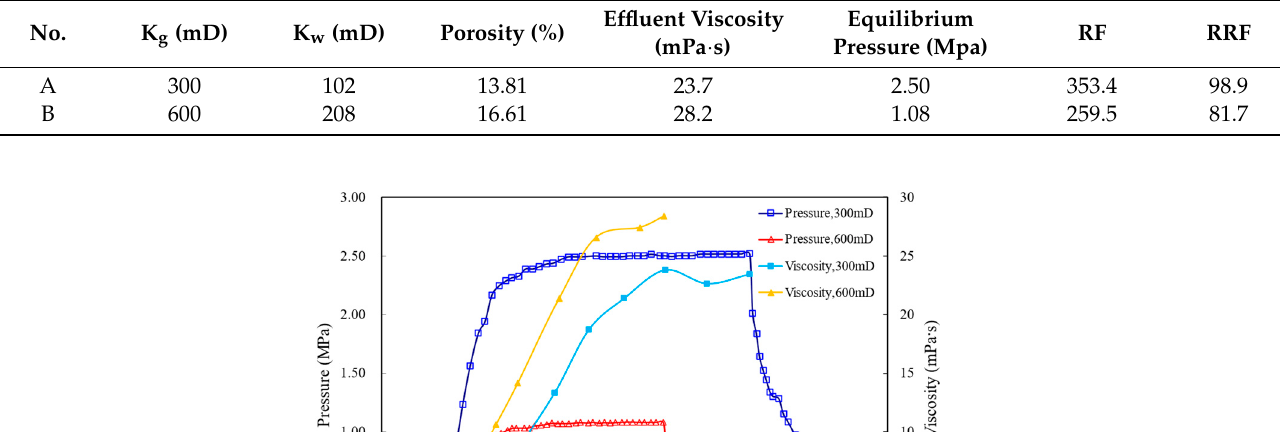
Table 6. Summary of results of the polymer injection capability experiment.